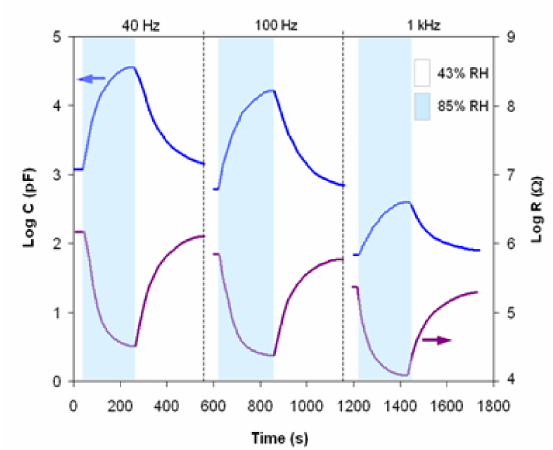
Figure 9. The response time characteristics for three working